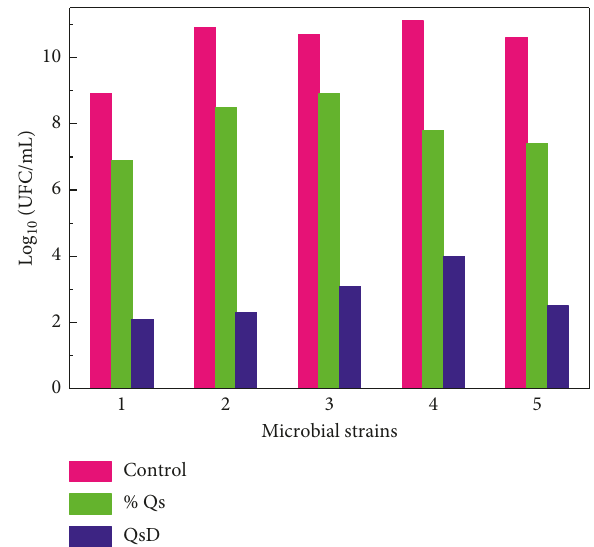
Figure 7: Antimicrobial activity of Qs and QsD against Staphy- lococcus aureus (1), Pantoea ananatis (2), Pseudomonas aeruginosa (3), Rautella planticola (4), and Escherichia coli